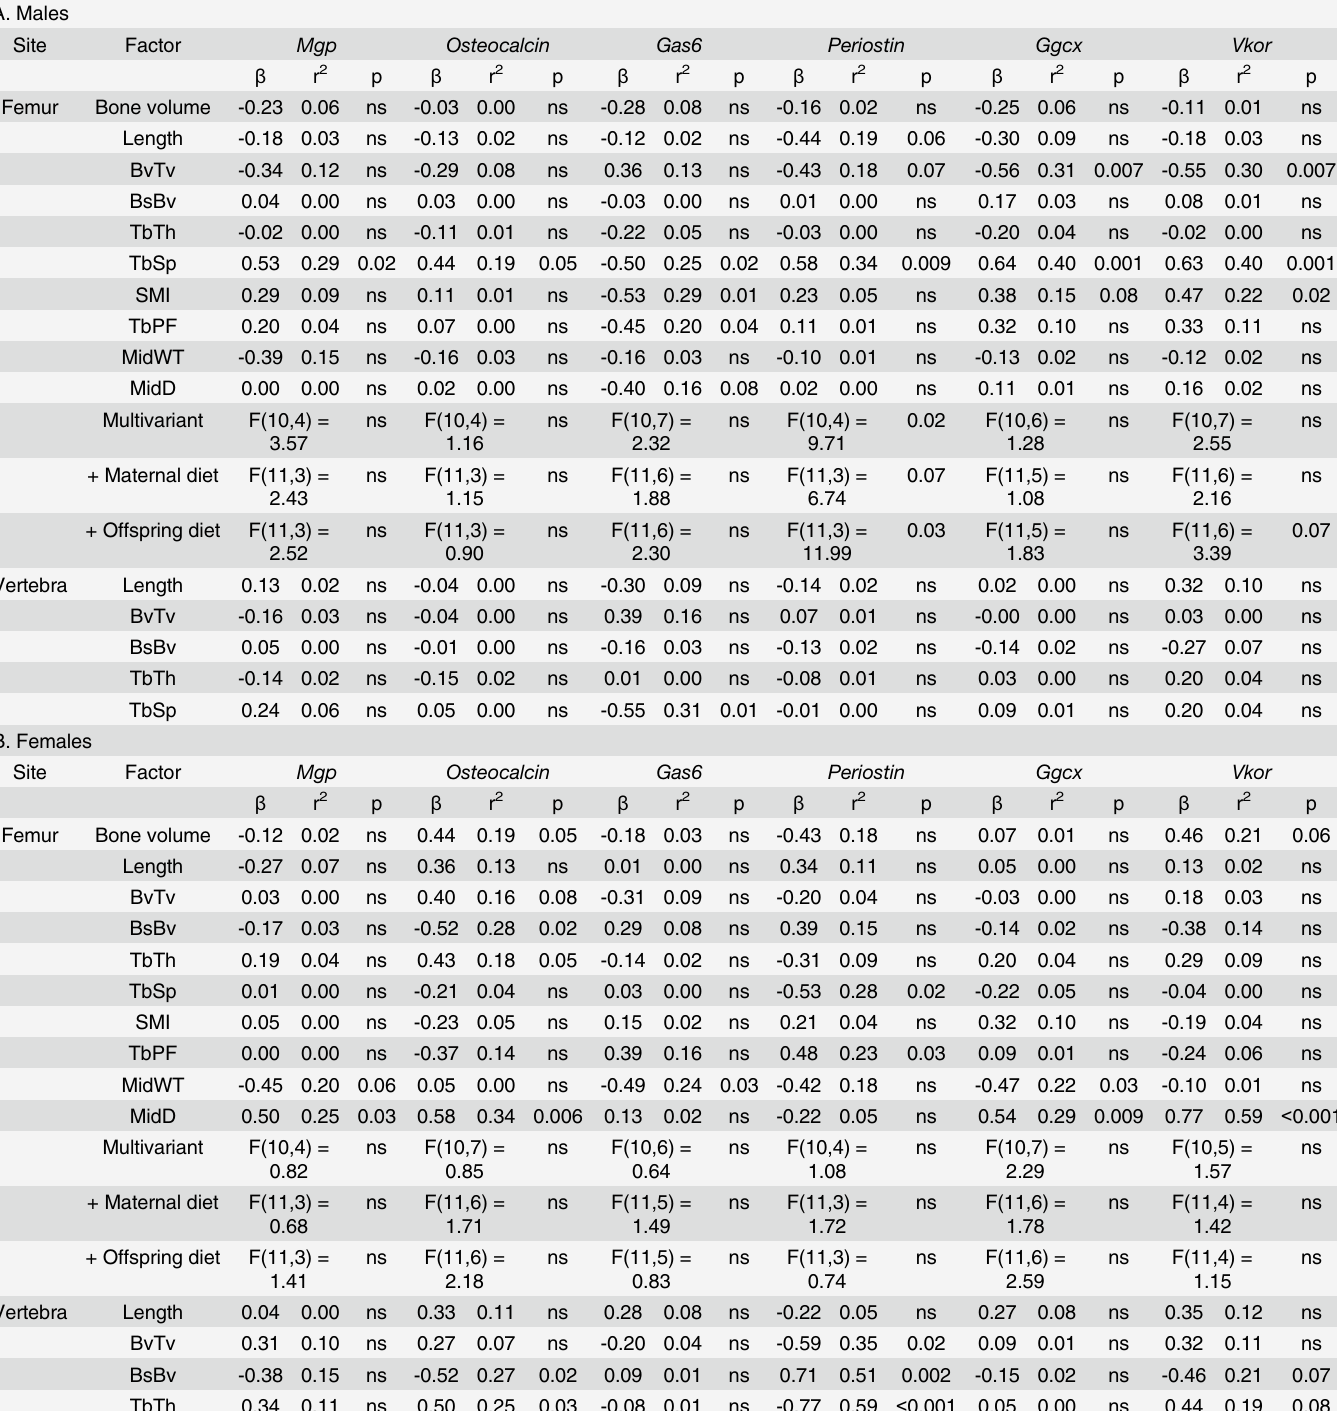
Table 3. Linear regression analysis between femoral vitamin K-dependent protein expression levels and bone structural factors of the femur or 3 rd lumbar vertebra. A.